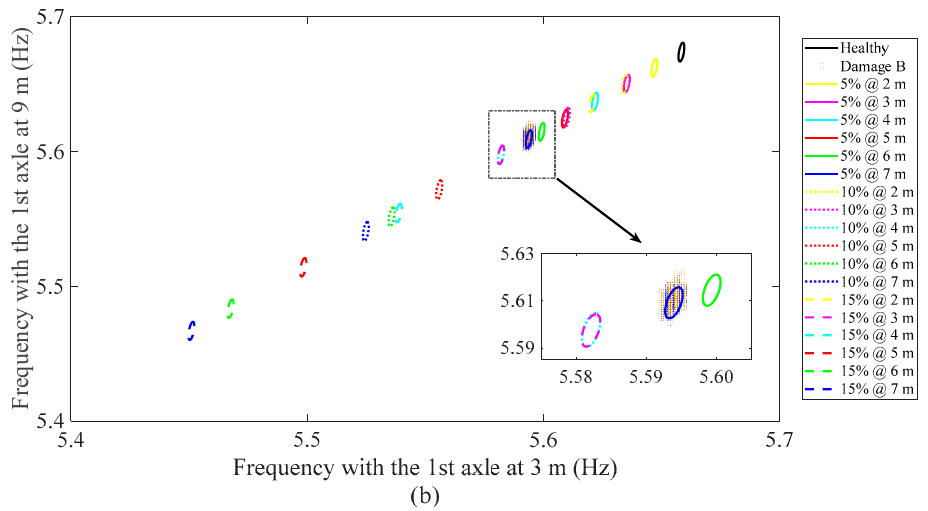
Figure 13. Comparison between transient forced-frequencies ( F 3 , F 9 ) due to the crossing of 1000 trucks and eigenvalue database for scenarios: ( a ) 15% crack at 5 m, and ( b ) 5% crack at 7 m.